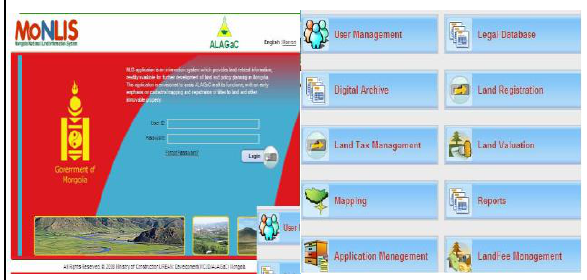
Figure 2. Mongolian NLIS, user-interface and its main functions